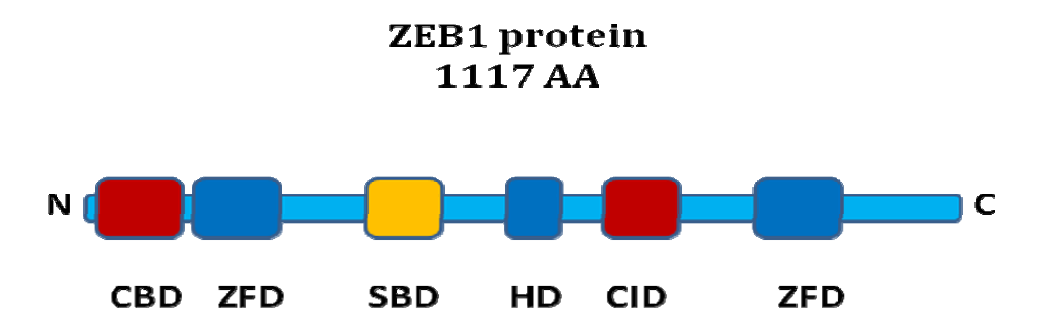
Figure 1. ZEB1 protein structure. Schematic representation of functional domains of the ZEB1 protein. ZFD: zinc finger domain, HD: homeodomain, SBD: Smad binding domain, CID: CtBP interaction domain, CBD: Coactivator binding domain. The ZFDs bind to DNA. The corepressor CtBP binds to the CID whereas the coactivators p300 and P/CAF interact with the CBD. R-Smads bind via the